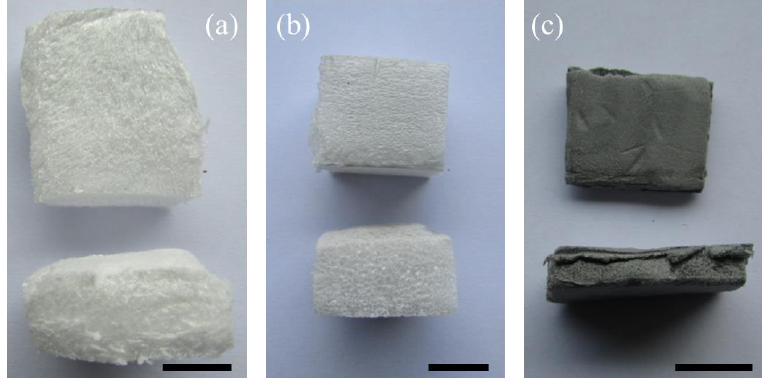
Figure 3. Optical camera images (upper: top view, lower: cross section view) of ( a ) neat PS foam, ( b ) ATP-PS 3, ( c ) ATP/PPy-PS 3. Scale bar: 1 cm.